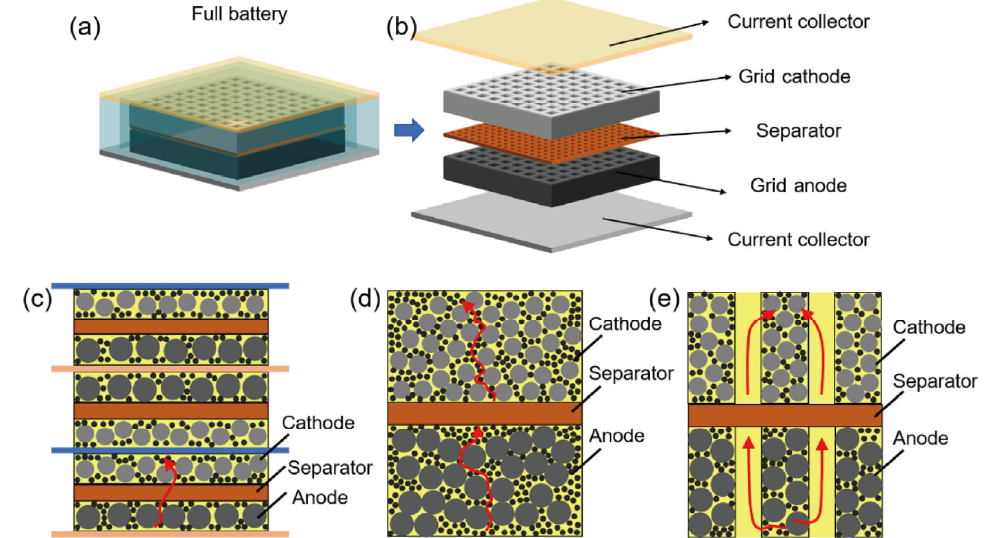
Fig. 1 Schematic of 3D Li-ion battery and its charge delivery mechanism: (a) 3D Li-ion battery based on 3D grid porous electrodes, (b) exploded view, (c) charge delivery in thin electrodes, (d) charge delivery in thick electrodes, and (e) charge delivery in 3D grid porous